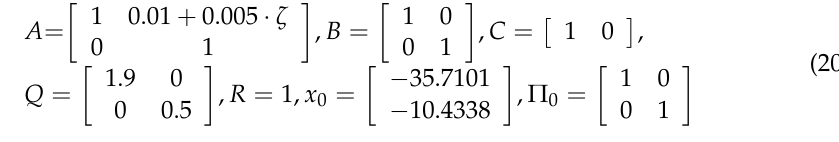
Measurement error The Kalman filter with nominal parameters The proposed robust design